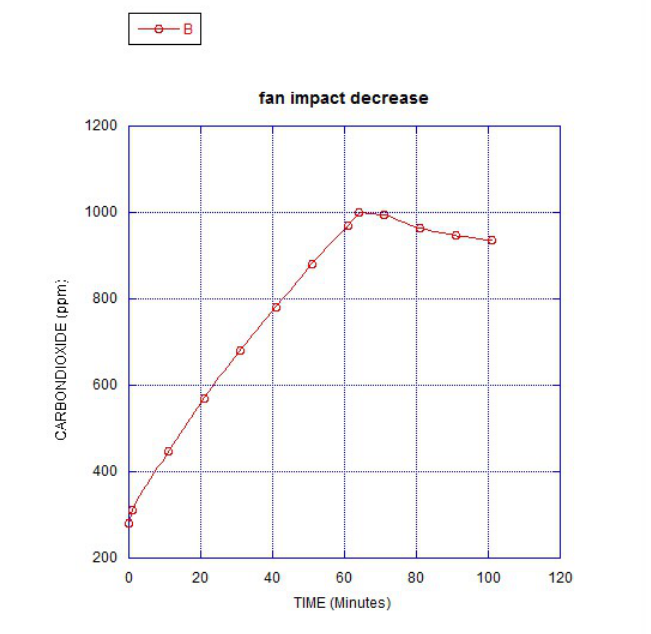
Figure 3. Operating a ventilation fan at a threshold of 1000 ppm